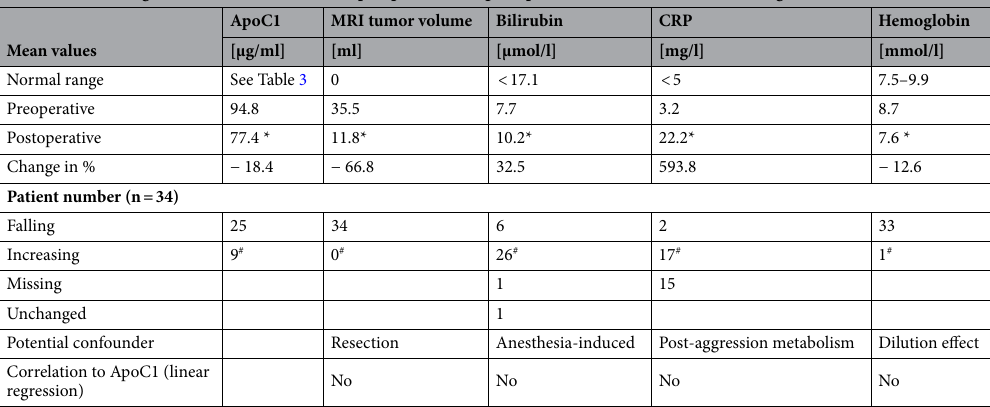
Table 2. Perioperative changes in ApoC1 level, tumor volume, bilirubin, CRP and hemoglobin. * p < 0.05 Mann–Whitney-U test, # p < 0.05 chi-square test.